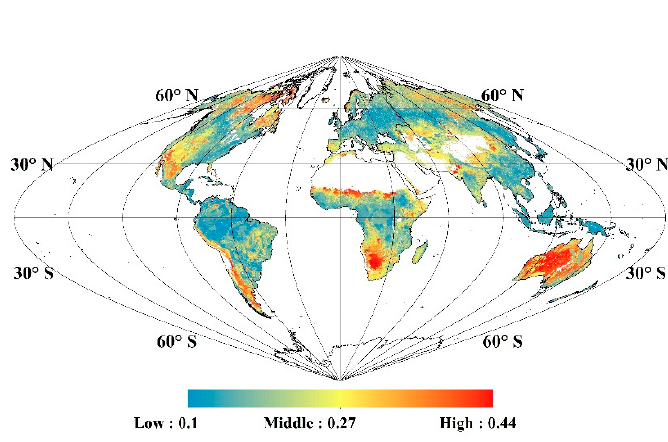
Figure 5. The global prior soil VIS albedo map obtained using the ECOCLIMAP sand fraction data and the yearly maximum FVC values derived from the MCD15A2H product and gap fraction model.